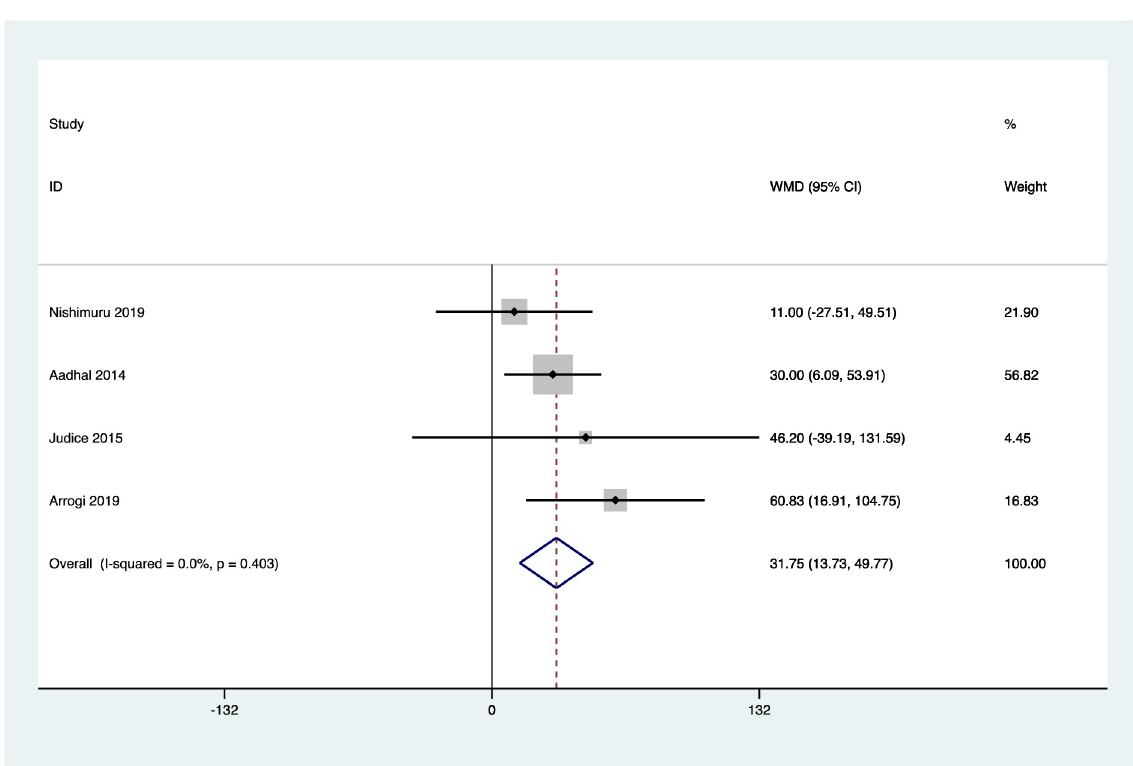
Fig 3. activPAL mean daily standing time (minutes). Heterogeneity chi-squared = 2.93 (d.f. = 3) p = 0.403; I-squared (variation in WMD attributable to heterogeneity) = 0.0%; Test of WMD = 0: z = 3.45 p = 0.001.